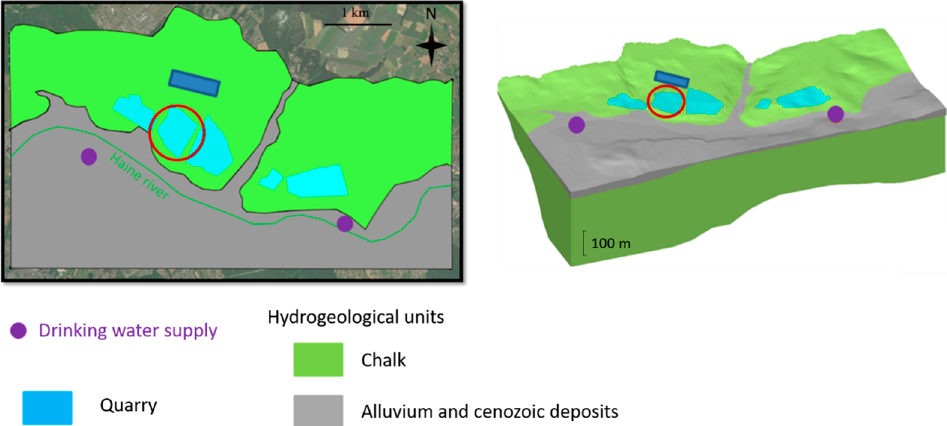
Figure 3. Plan view and 3D view of the hydrogeological model. The red circle highlights the open pit chalk quarry where PSH operations were studied.